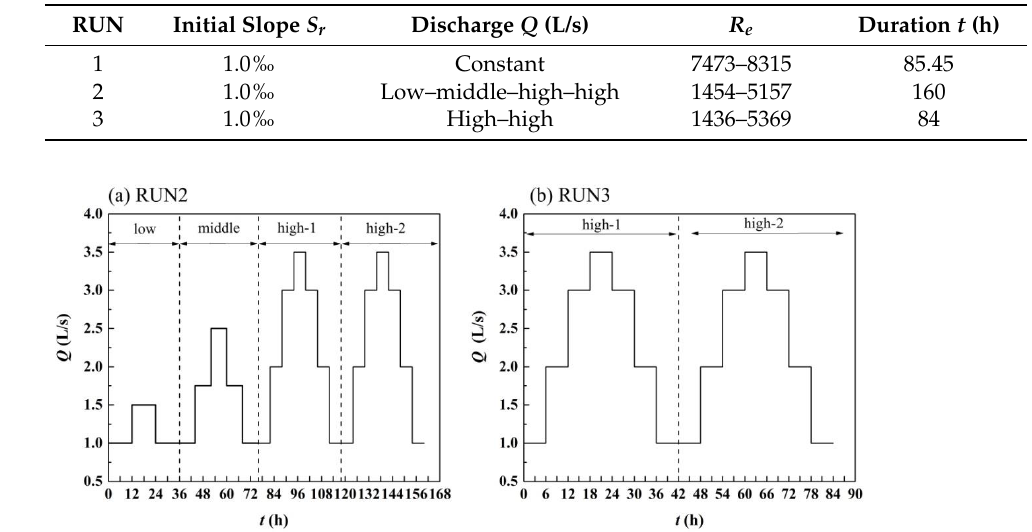
Table 1. Experimental runs.